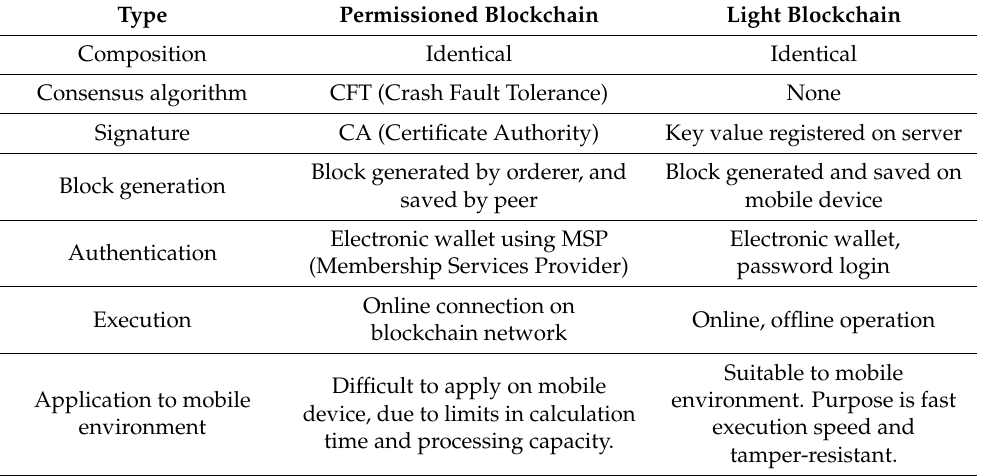
Table 1. Comparison of blockchain